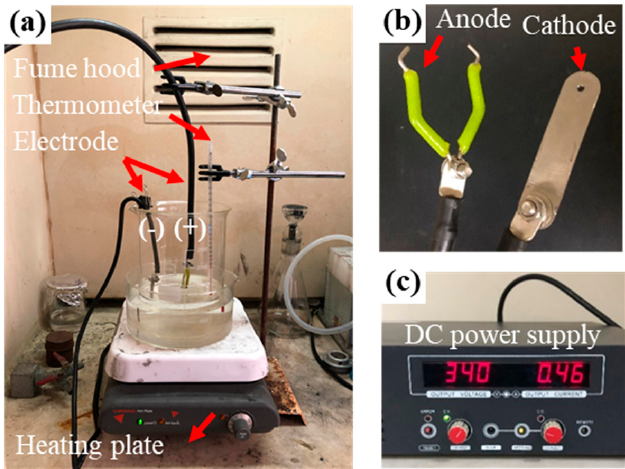
Figure 3. Experimental device for plasma electrolytic polishing: ( a ) PEP system; ( b ) zoomed in observation of electrode; ( c ) DC power supply.